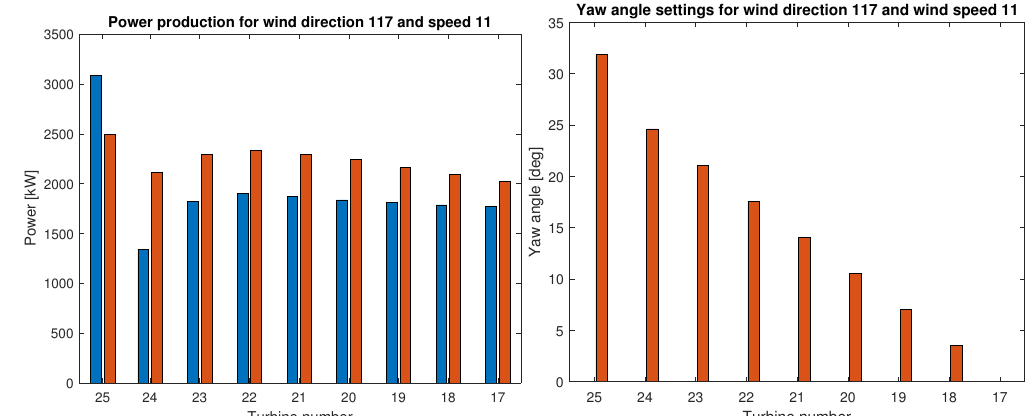
Figure 5. Power production ( left ) and optimal yaw misalignments ( right ) for the row of wind turbines T16-T7 for wind direction 117deg and wind speed 11 m/s. The blue ( left ) bars represent the reference case, while the red ( right ) bars represent wake redirection